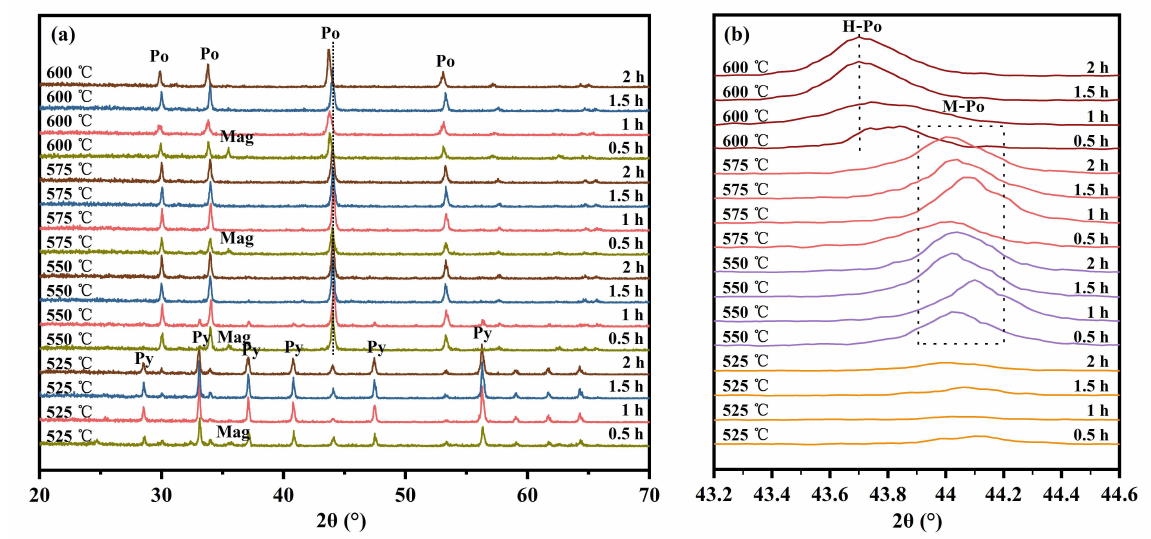
Figure 4. ( a ) XRD patterns of sulfidation products obtained under various temperatures and times (sulfidation conditions: 525–600 ◦ C, 0.5–2 h, 40 mL/L, 3% H 2 S and 97% N 2 balance gas); ( b ) partially enlarged areas (2 θ : 43.2–44.6 ◦ ) of ( a